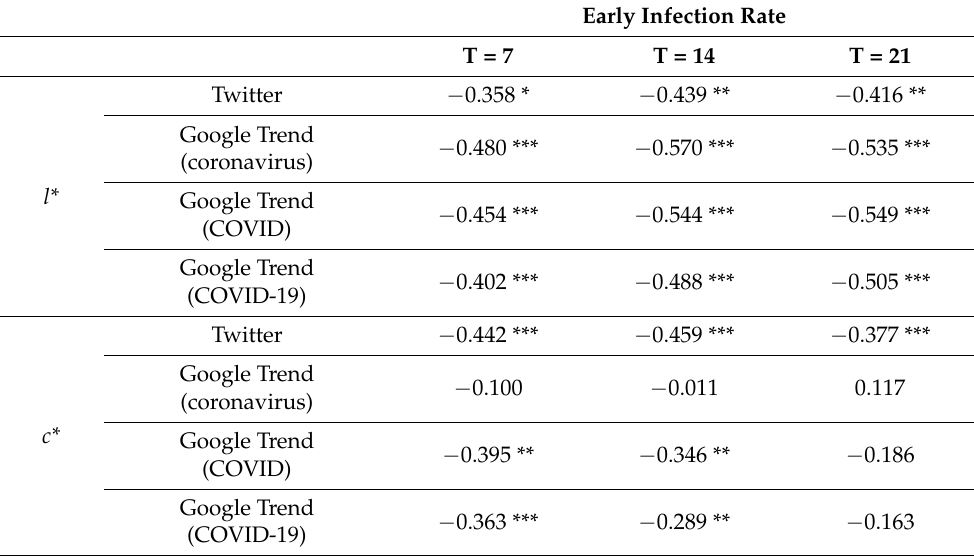
Table 2. The correlation coefficient between early infection rate for different T (number of days) and l* and c* from Internet data ( n = 50). Similar to Table 1, the stars represent the significance level, * p < 0.1, ** p < 0.05, *** p <